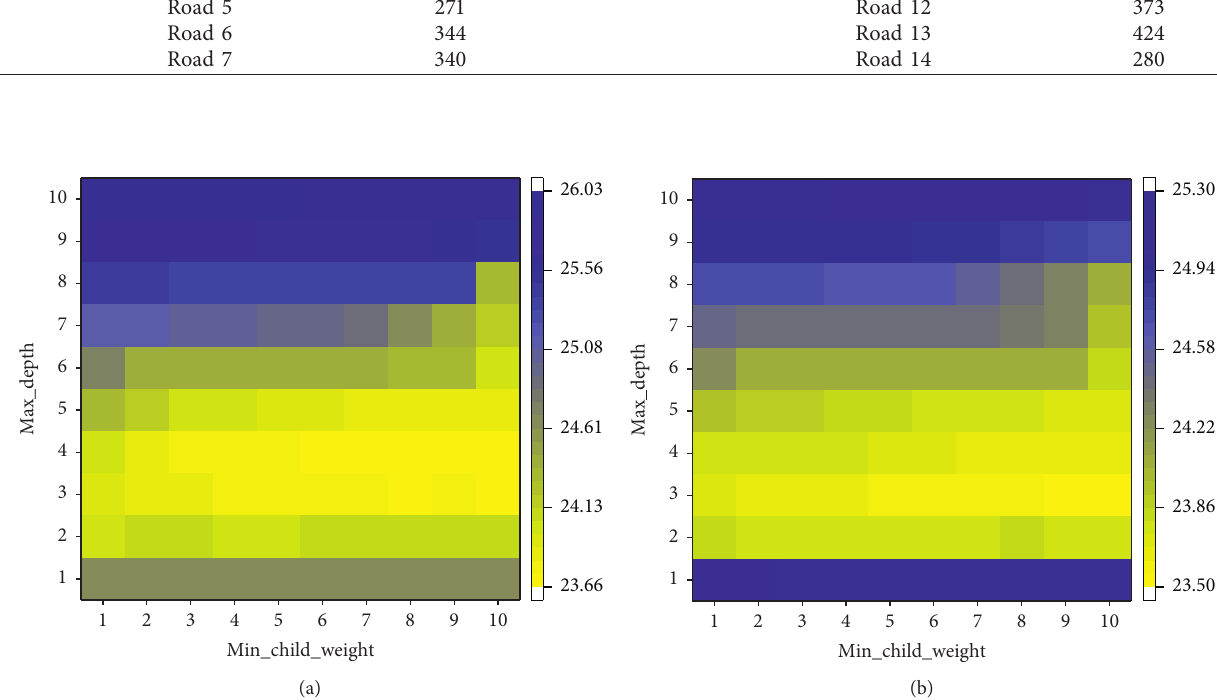
Figure 6: max_depth and min_child_weigh up-direction and down-direction parameter adjustment